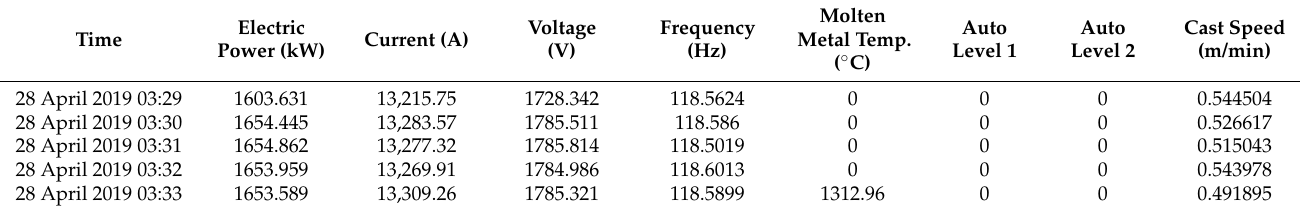
Table 1. Real-time sample